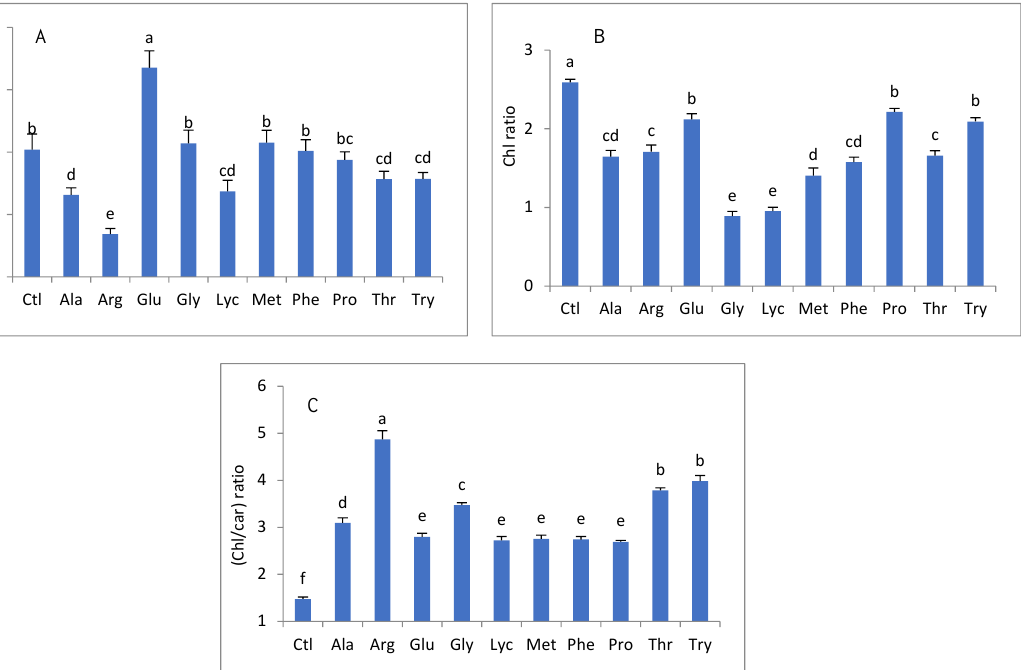
Figure 7. Effect of priming onion seeds with amino acids. ( A )—Carotene contents, µ g/g FW; ( B )—Chla/Chlb ratio; ( C )—Chl/Car ratio. Ctl (Control); Ala (Alanine); Arg (Arginine); Glu (Glu- tamine); Gly (Glycine); Lys (Lysine); Met (Methionine); Phy (Phenylalanine); Pro (Proline); Thr (threonine); Try (tryptophan). Columns that share the same letter(s) are not statistically significant at p ≤